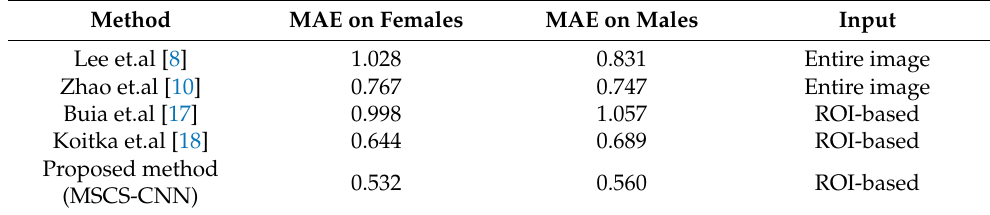
Table 9. MAE comparison with other bone age assessment